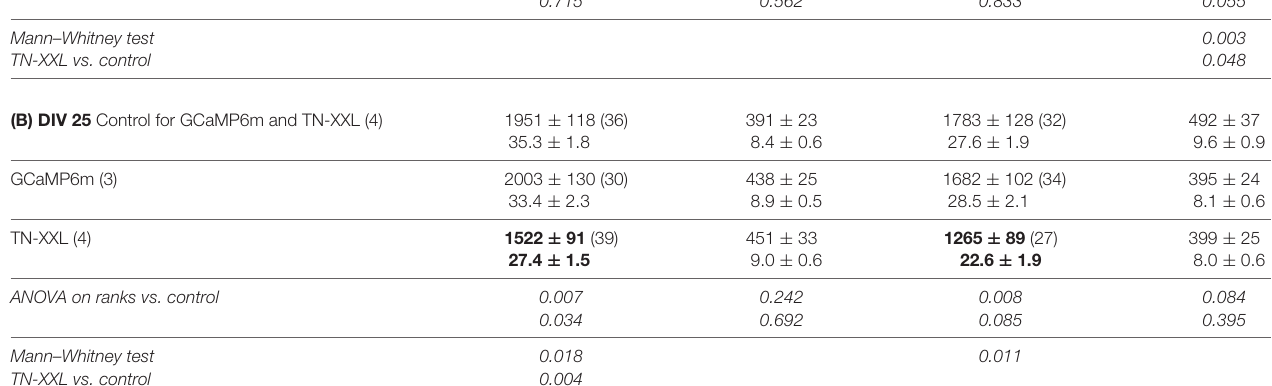
TABLE 4 | Measures of apical and basal dendrites of pyramidal neurons of layers II/III and V/VI expressing GCaMP6m-X C vs. batch-internal EGFP expressing neurons as control. Pyramidal cells overexpressing GCaMP6m-X C at DIV 14 and DIV 22